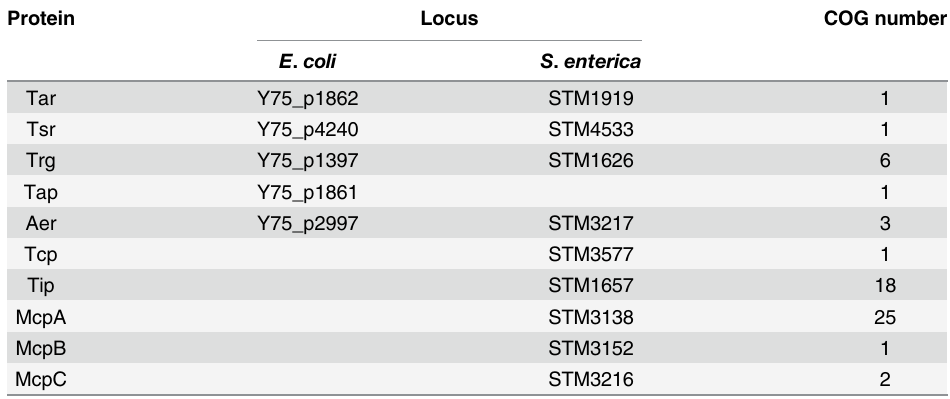
Fig 3. Clusters of orthologous groups of chemoreceptors from 43 enterobacterial genomes. Each node represents a chemoreceptor sequence. MCPs from E . coli (blue) and S . enterica (red) are labeled by name and a corresponding COG number. See S1 Dataset and Materials and Methods for details. doi:10.1371/journal.pcbi.1004723.g003 Table 1. COG assignment of chemoreceptors in E . coli and S. enterica